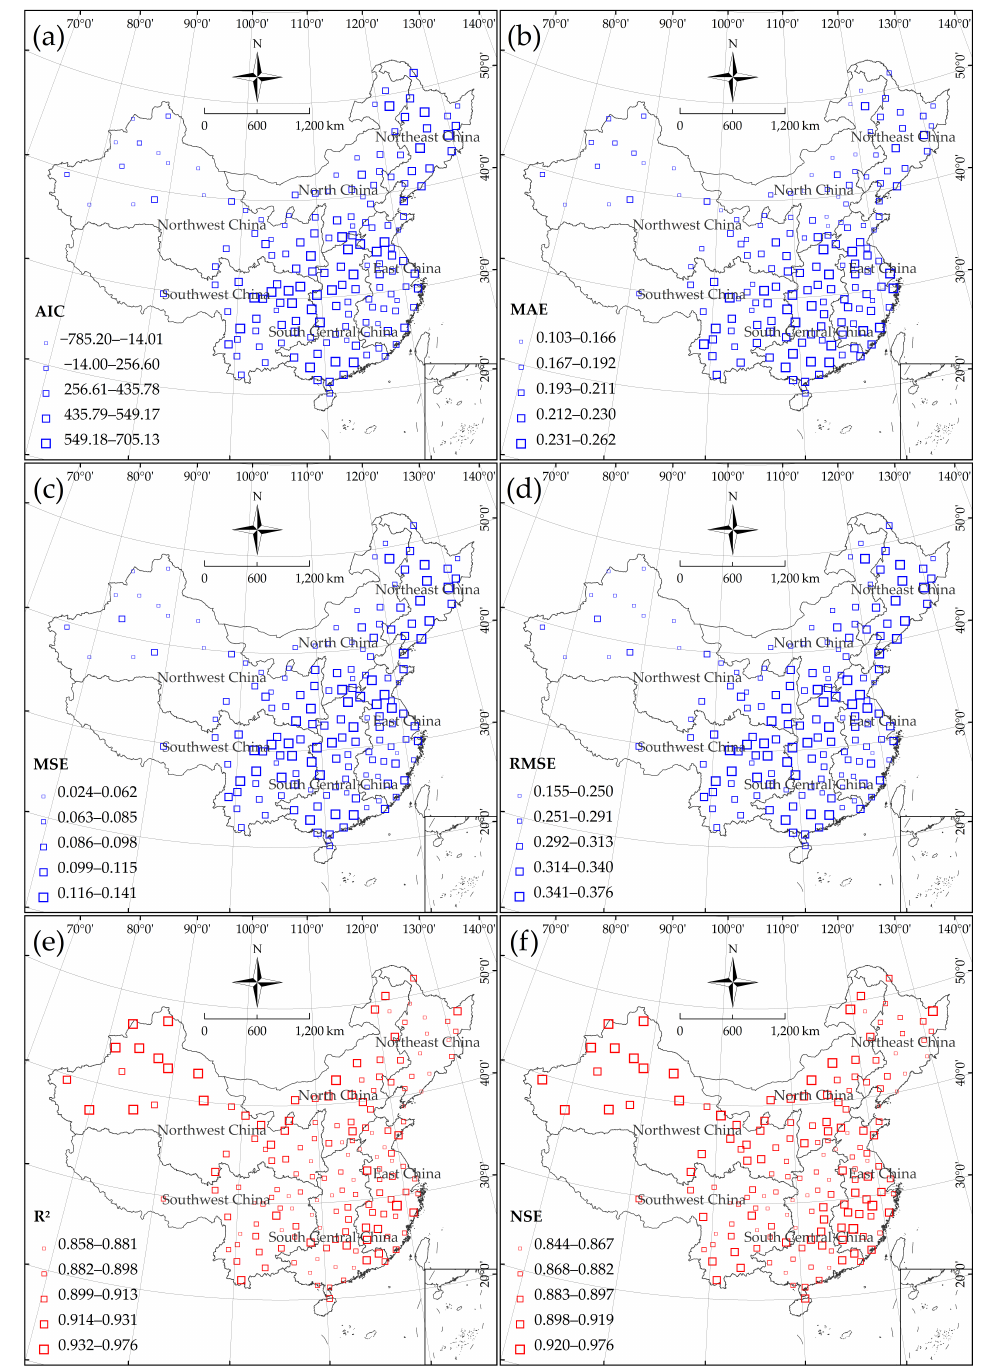
Figure 9. Spatial distribution of performance metrics for drought forecasting based on the SARIMA model at 160 stations over China: ( a ) AIC; ( b ) MAE; ( c ) MSE; ( d ) RMSE; ( e ) R 2 ; ( f ) NSE. Blue denotes the error measure (the smaller value, the higher the accuracy); red denotes the accuracy measure (the larger the value, the higher the